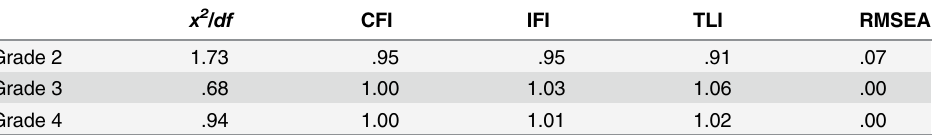
Table 6. The fit indexes of three